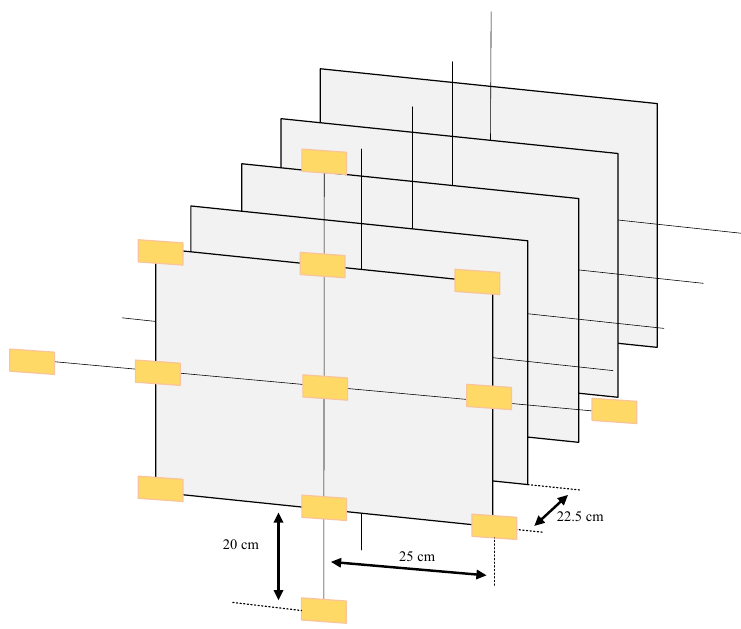
Figure 6. Diagram of the measurement point locations.